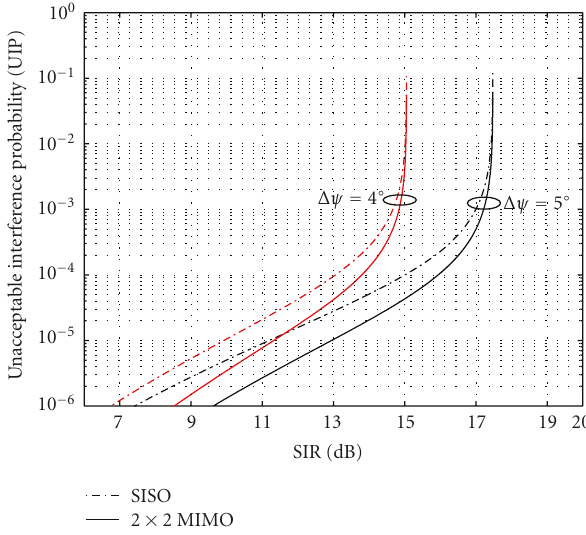
Figure 7: UIP versus SIR for a satellite 2 × 2 MIMO diversity sys- tem employing receive antenna selection. Relevant SISO case is also plotted for comparison. E ff ect of system availability p avail , operating frequency f , and rain climatic conditions over the serviced area.